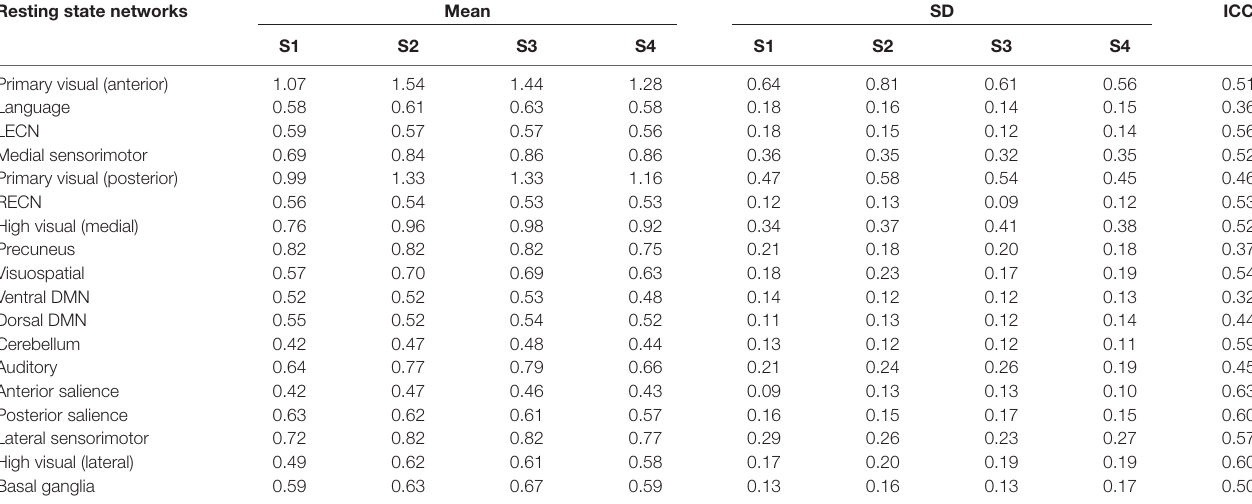
TABLE 3 | Mean and standard deviation (SD) of within-network functional connectivity (WNFC) values across participants for each session and the estimated intra-class correlation (ICC) value. Resting state networks Mean